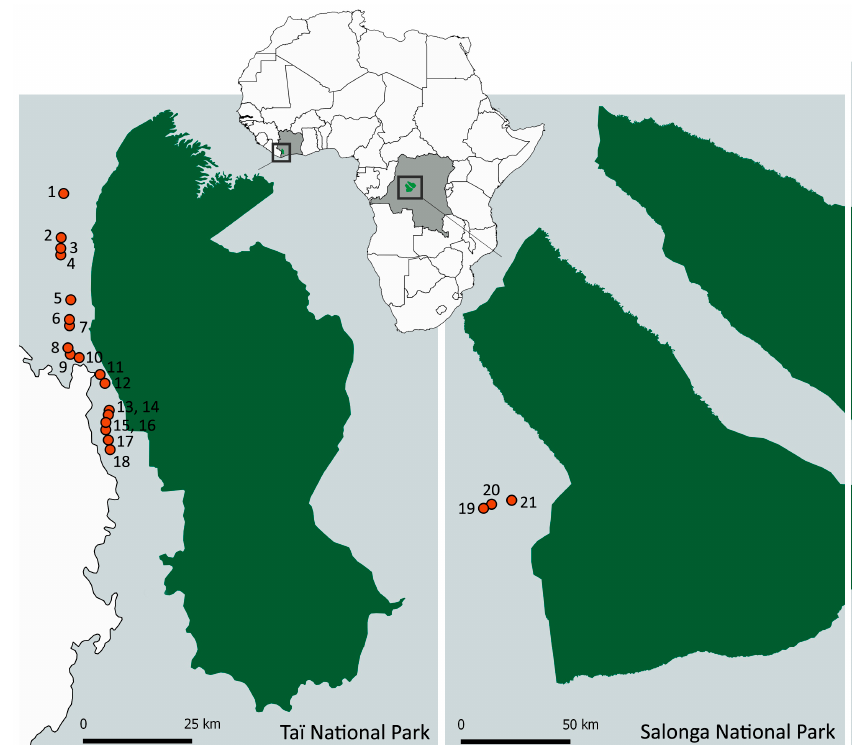
Figure 1. Rural sampling locations near Taï National Park, Côte d’Ivoire (left panel) and Salonga National Park, Democratic Republic of the Congo (right panel). National Parks in dark green. 1, Zagne (Zag). 2, Tienkoula (Tie). 3, Goulegui Beoue (GouB). 4, Djiboubaye (Dji). 5, Keibly (Kei). 6, Zaipobly (Zai). 7, Gahably (Gah). 8, Daobly (Dao). 9, Ponan (Pon). 10, Taï (Tai). 11, Gouleako (Gou). 12, Pauleoula (Pau). 13, Portgentil (Por). 14, Djereoula (Dje). 15, Tienkoula (Tien). 16, Tieleoula (Tiel). 17, Ziriglo (Zir). 18, Sakre (Sak). 19, Bekombo (Bek). 20, Lompole (Lom). 21, Ipope/Nganda (Ipo/Nga). Blood was collected by venepuncture into ethylenediaminetetraacetic acid (EDTA) tubes by medical personnel from the respective countries. After centrifugation, serum was transferred into cryotubes and stored frozen until laboratory analyses were done at the Robert Koch Institute in Berlin,